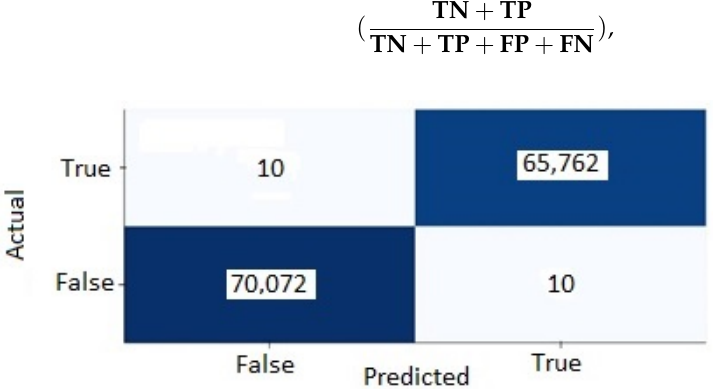
Figure 5. Confusion matrix of the first model.